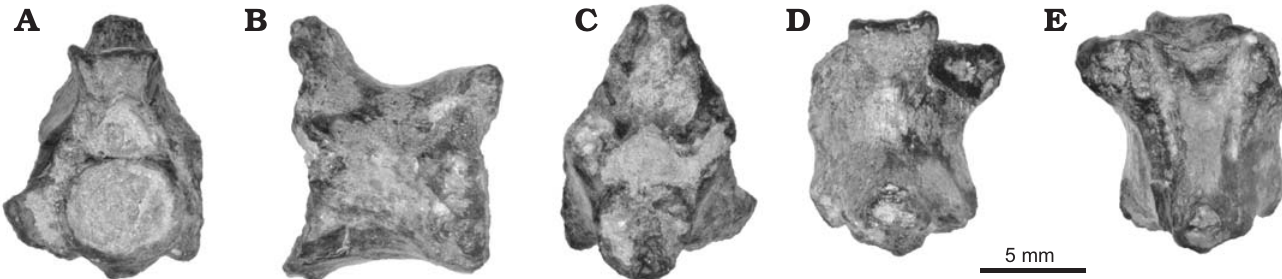
Fig. 6. Vertebra of the nigerophiid snake Amananulam sanogoi gen. et sp. nov. (CNRST-SUNY 426) from the Paleocene Teberemt Formation (phosphate of Mali-19), Mali; in anterior ( A ), lateral ( B ), posterior ( C ), dorsal ( D ), and ventral ( E )